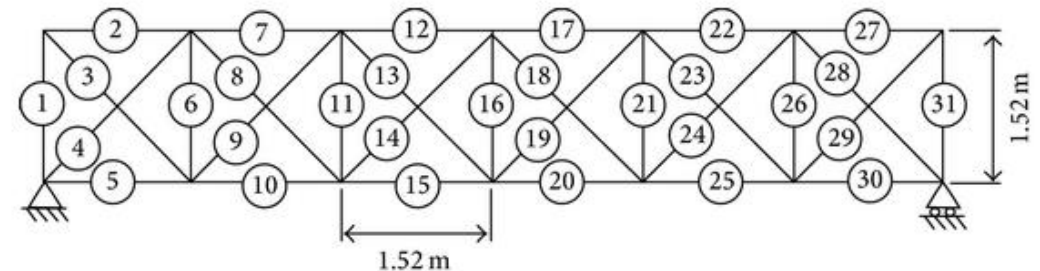
Figure 4. The 31-bar planar truss. Table 2. Damage scenarios of the planar truss.